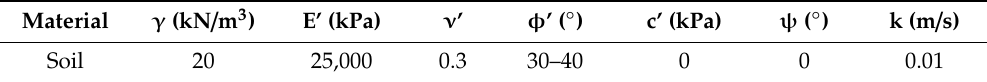
Figure 6. Mesh employed in the analysis.